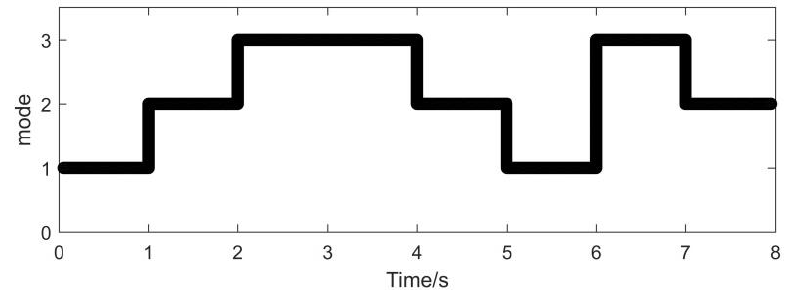
Figure 7. The switching signals σ ( k )